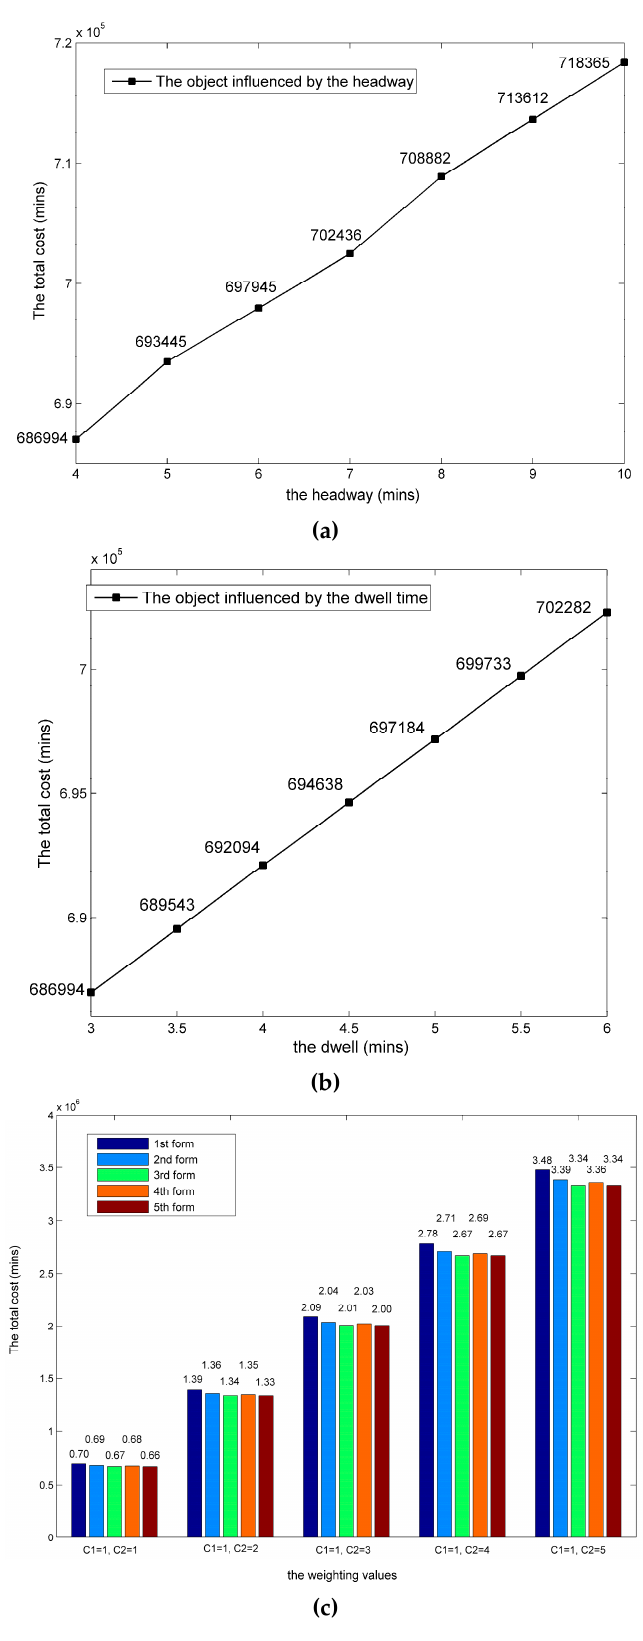
Figure 4. Objective versus multiple parameters changing. ( a ) Objective versus dwell time. ( b ) Objective versus headway. ( c ) Objective versus weighting values ( c 1 , c 2 ).